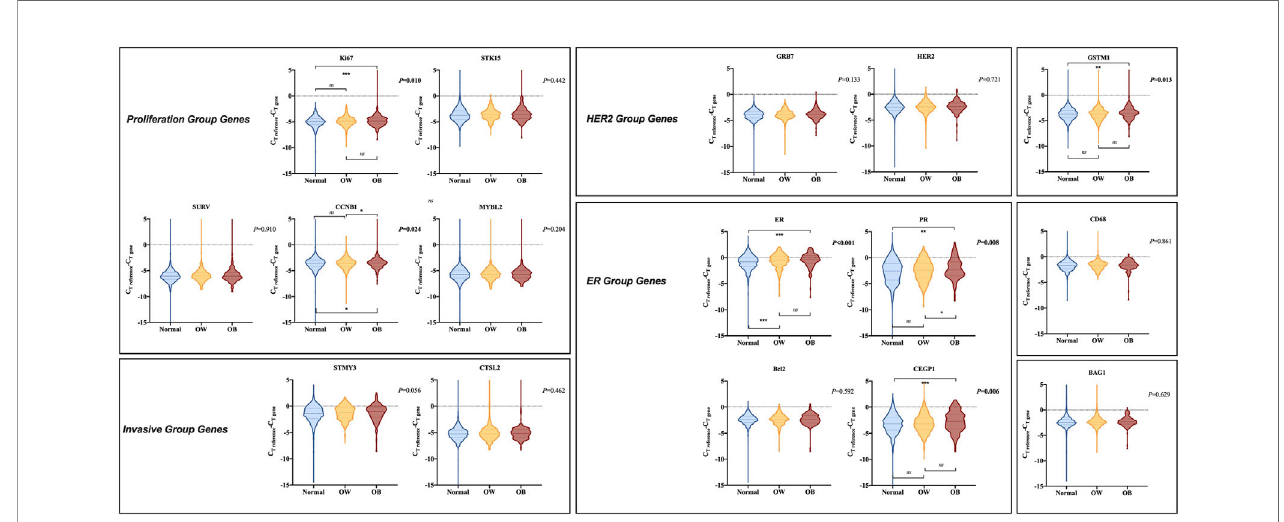
FIGURE 3 | Comparison of gene expression in 21-gene RS panel by BMI status. The violin plots refer to the expression of a certain gene. The dashed lines and the dotted lines refer to the median and quartiles, respectively. BMI, body mass index; C T , cycle threshold; OW, overweight; OB, obese; HER2, human epidermal growth factor receptor 2; ER, estrogen